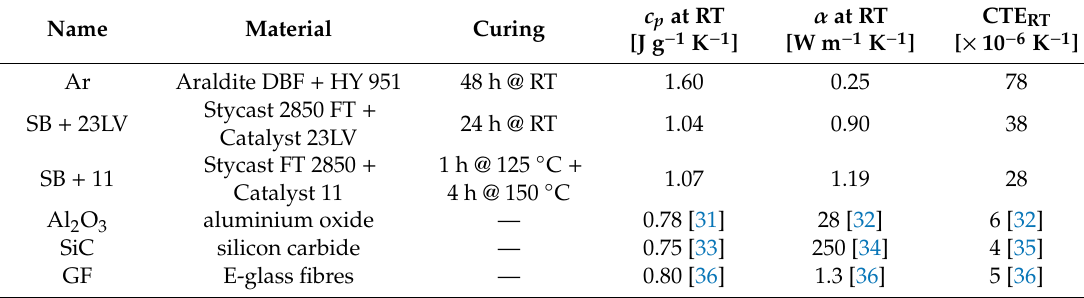
Figure 1. Distribution of ceramic particles in composite of Stycast 2850 FT resin (SB + 11) with 20% SiC given by mapping of Al, O, Si and C using X-ray energy-dispersive analysis. Table 1. Selected properties of used materials for preparation of